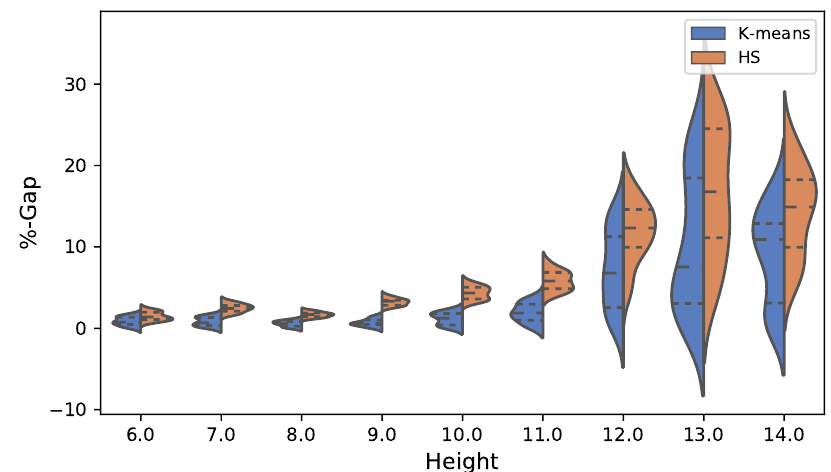
Figure 13. Violin plot comparison between k-means and HS results for cost in euros.